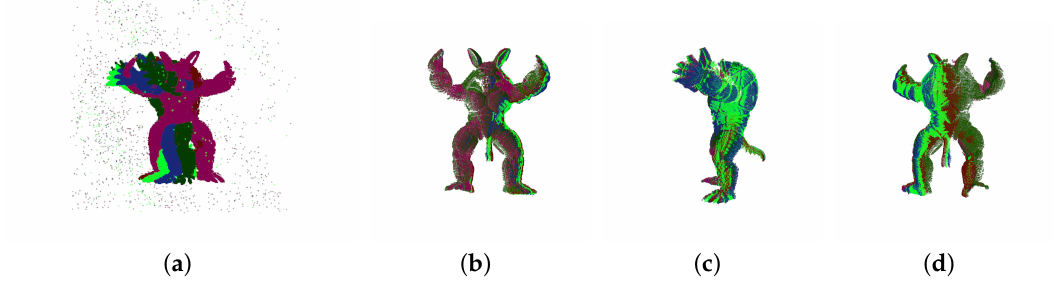
Figure 12. Multi-view registration through our approach to the outlier Armadillo model of Stanford dataset. ( a ) Multi view Armadillo point clouds with outliers; ( b – d ) are the registration results in three views.